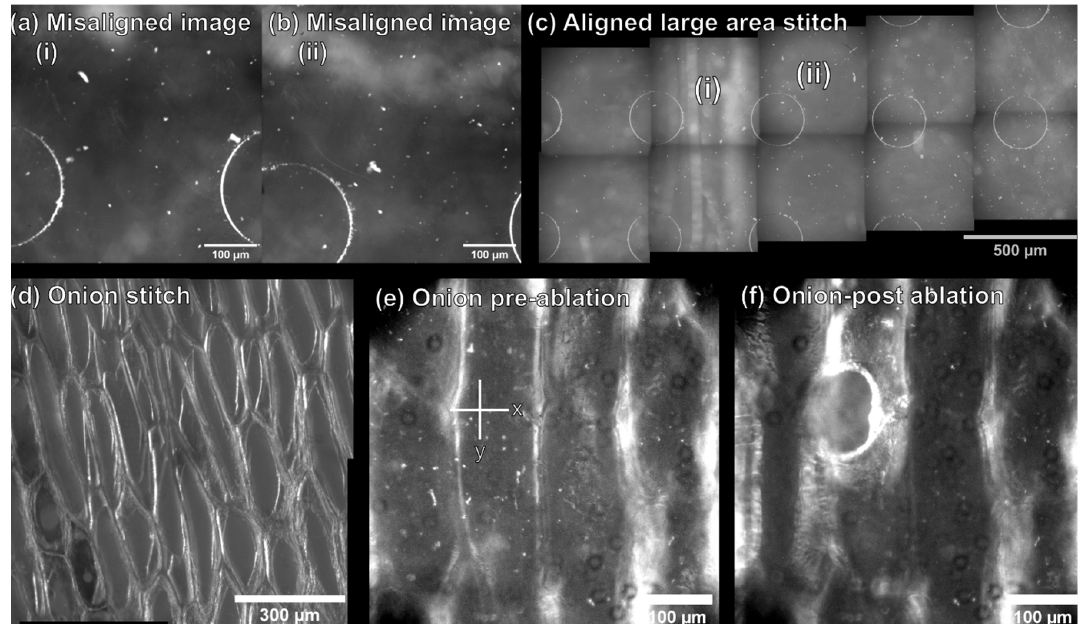
Figure 2. Optimizing the optical microscopy component for feature-based image stitching and single cell identification. ( a , b ) Separate image tiles from a microwell chip with vertical misalignment (100 µm), where ( c ) the misaligned tiles (i) and (ii) are recombined into an aligned stitched mosaic image based on feature recognition. ( d ) Image tiles from A. Cepa tissue are aligned and stitched together into a 2 × 2 stitched mosaic image. ( e ) An individual A. Cepa . epidermal cell prior to laser ablation, cell coordinates are extracted as stage coordinates (X, Y; µm, µm), and ( f ) the same single cell after LAESI-DTIMS sampling.